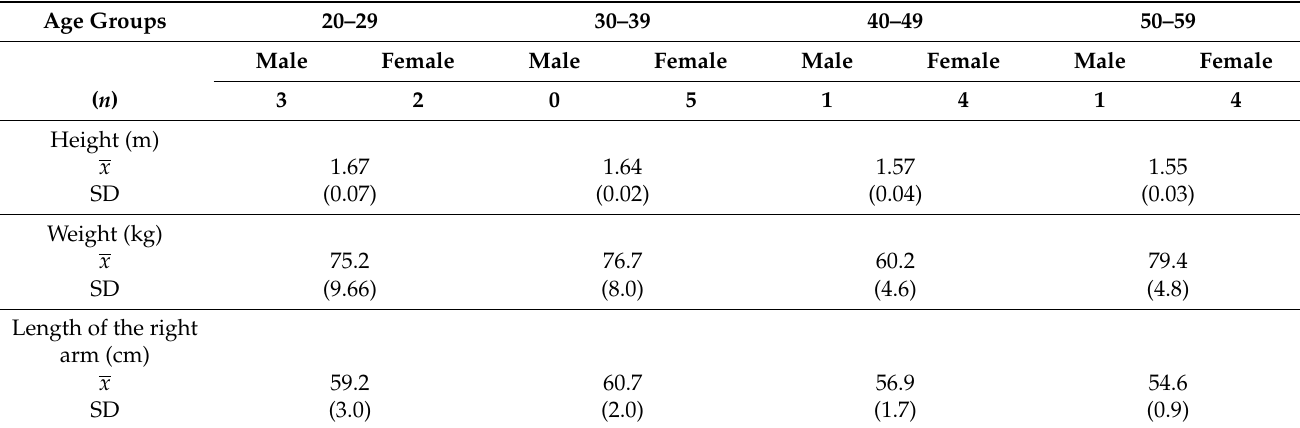
Table 1. Characteristics and demography of the sample analysed ( n =